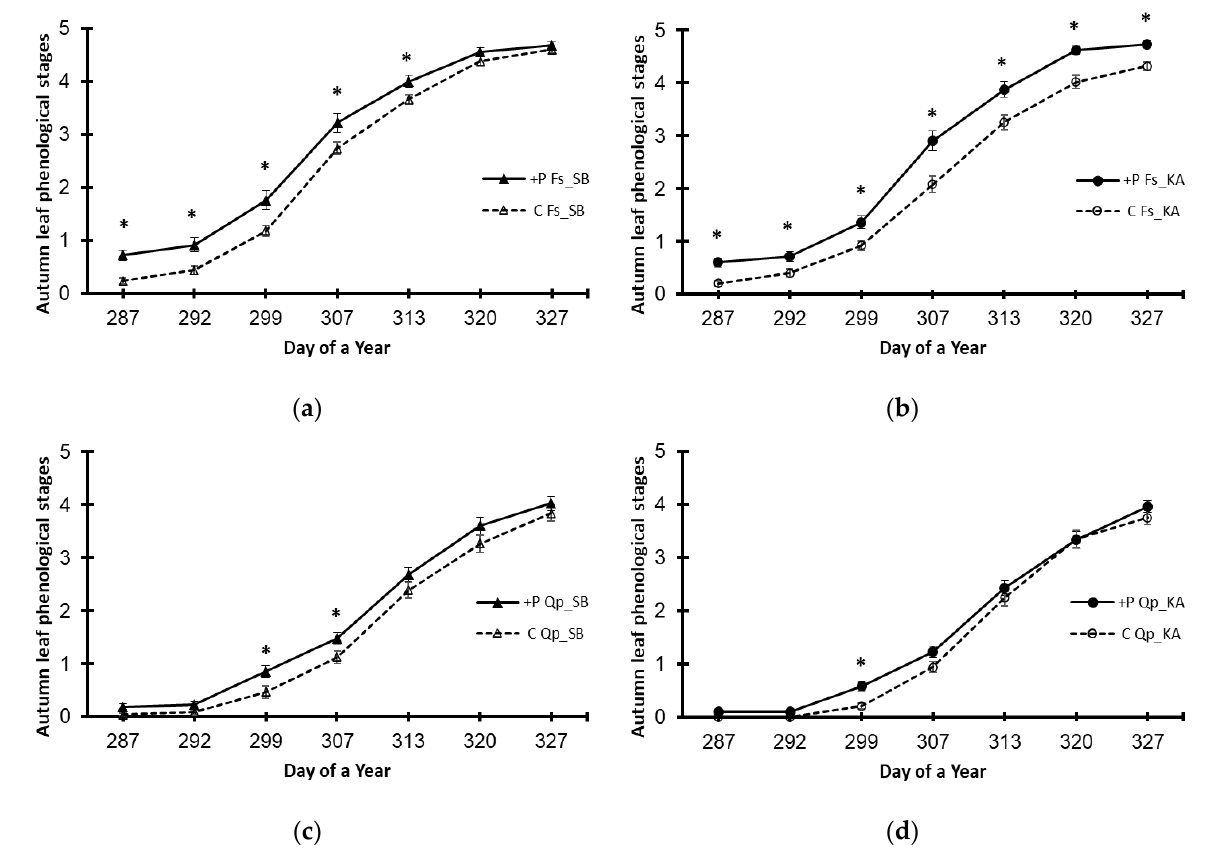
Figure 2. Autumn leaf phenologies of beech (Fs) and oak (Qp) saplings in 2021, by provenance and treatment: ( a ) beech provenance SB; ( b ) beech provenance KA; ( c ) oak provenance SB; ( d ) oak prov- enance KA. +P treatment — elevated phosphorus; C — control (no phosphorus added). The markers represent the means ± S.E. ( n = 50). A star denotes a statistically significant difference between the treatments on a given day of the year ( p < 0.05).